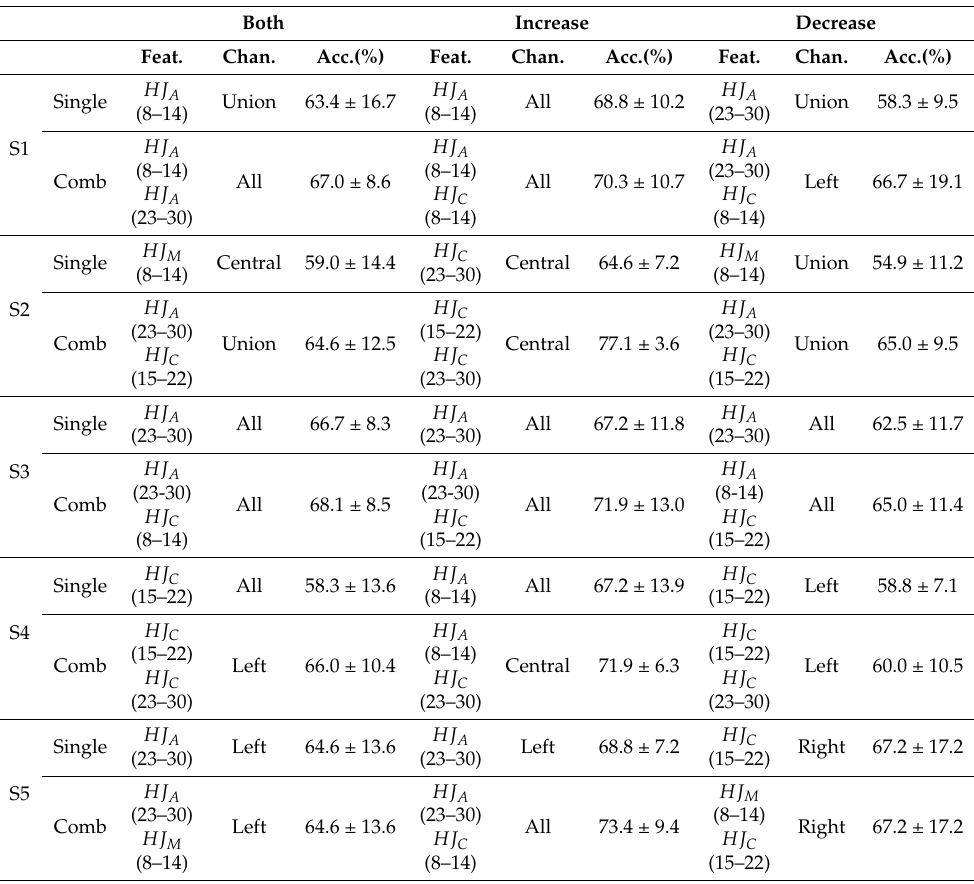
Table 3. Comparative table of best results according to feature selection. The table compares the best results for total accuracy depending on the paradigm and electrode configuration as Single or Combined (Comb) for the offline